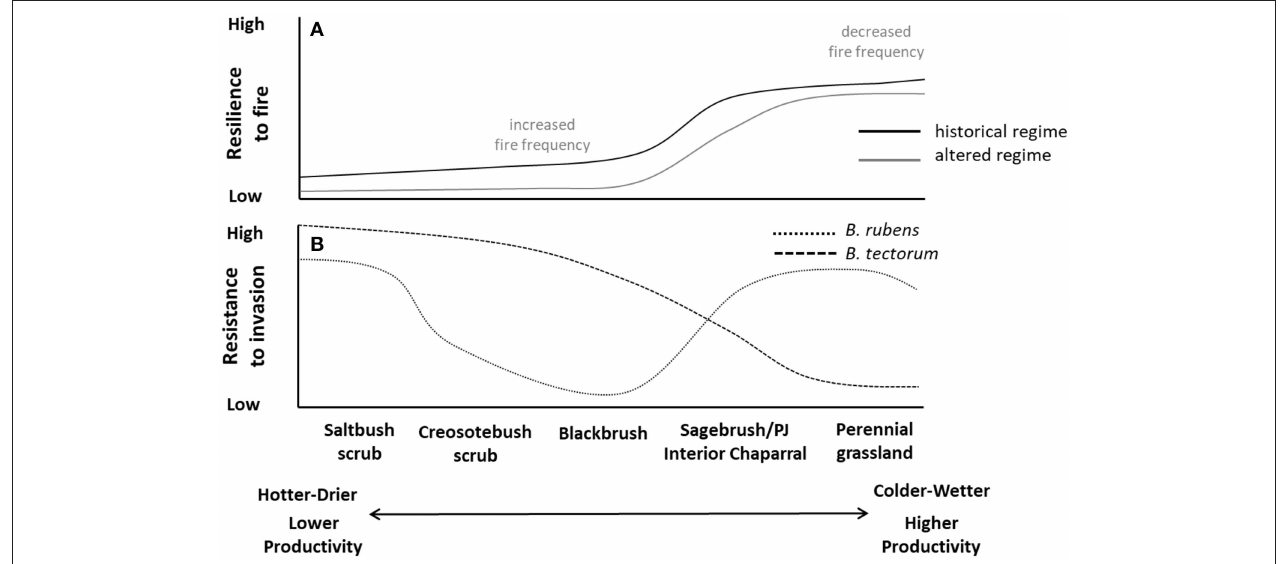
FIGURE 8 | Hypothetical (A) resilience to historical and altered fire regimes (primary altered regime characteristic labeled in gray) and (B) resistance to common invasive annual grass species in the Mojave Desert. Adapted from Brooks et al. (2016).